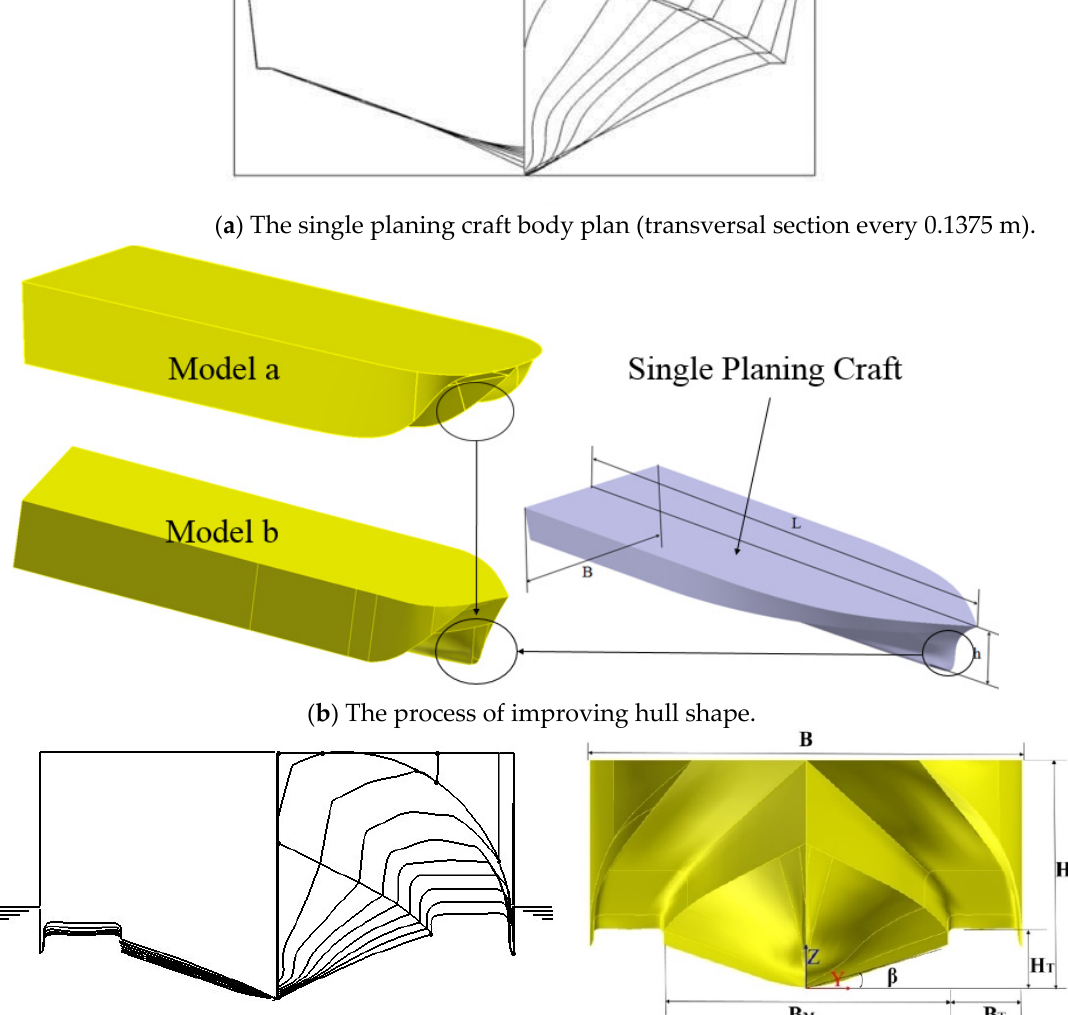
Figure 12. Improved hull.